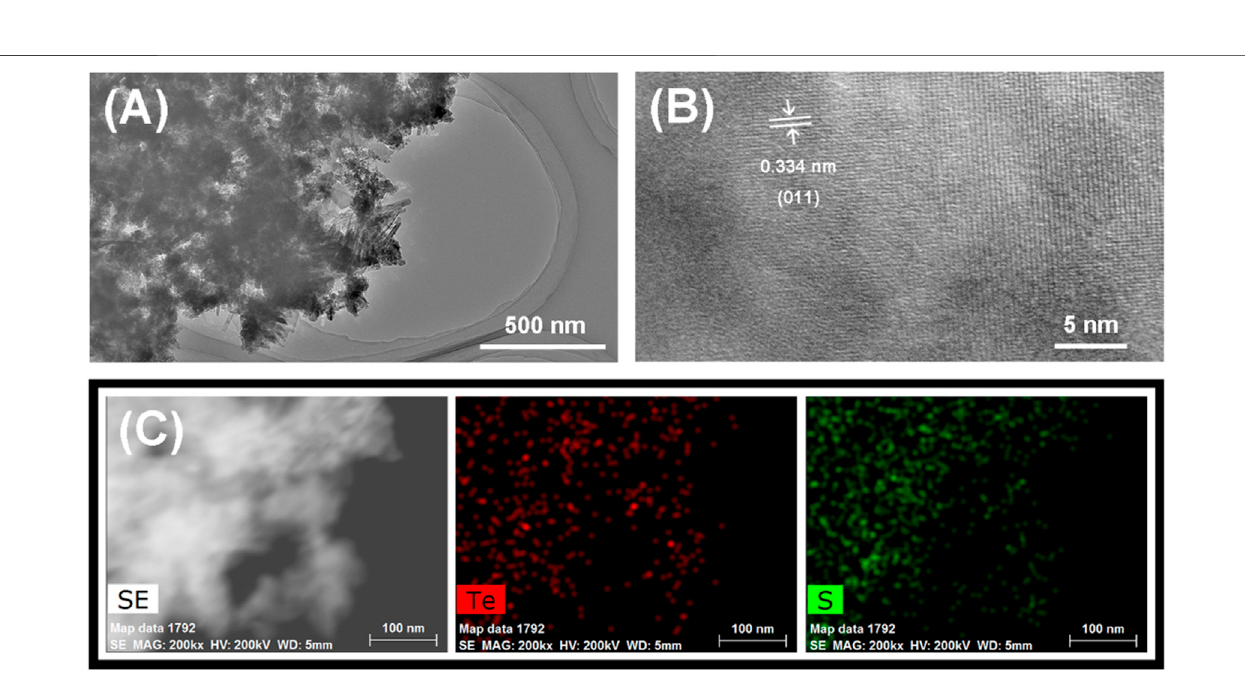
Frontiers in Chemistry |